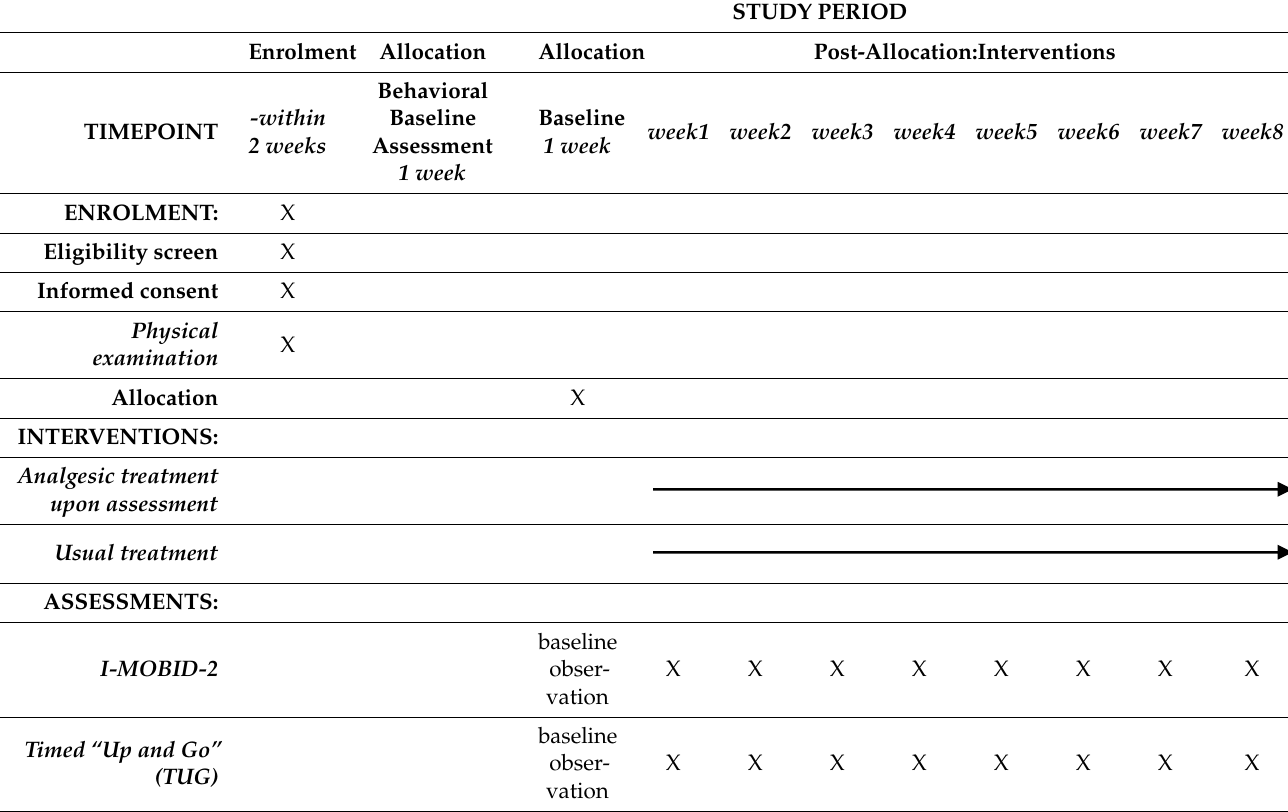
Table 1. Timeline of pain assessment.